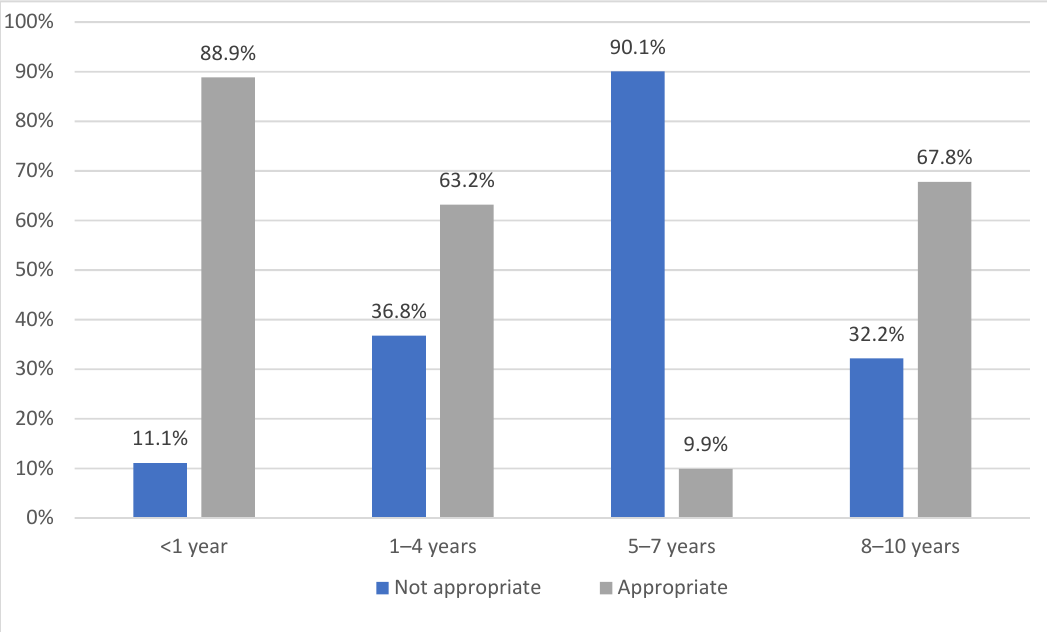
Figure 4. Appropriateness of restraint use by age group for the eldest child.